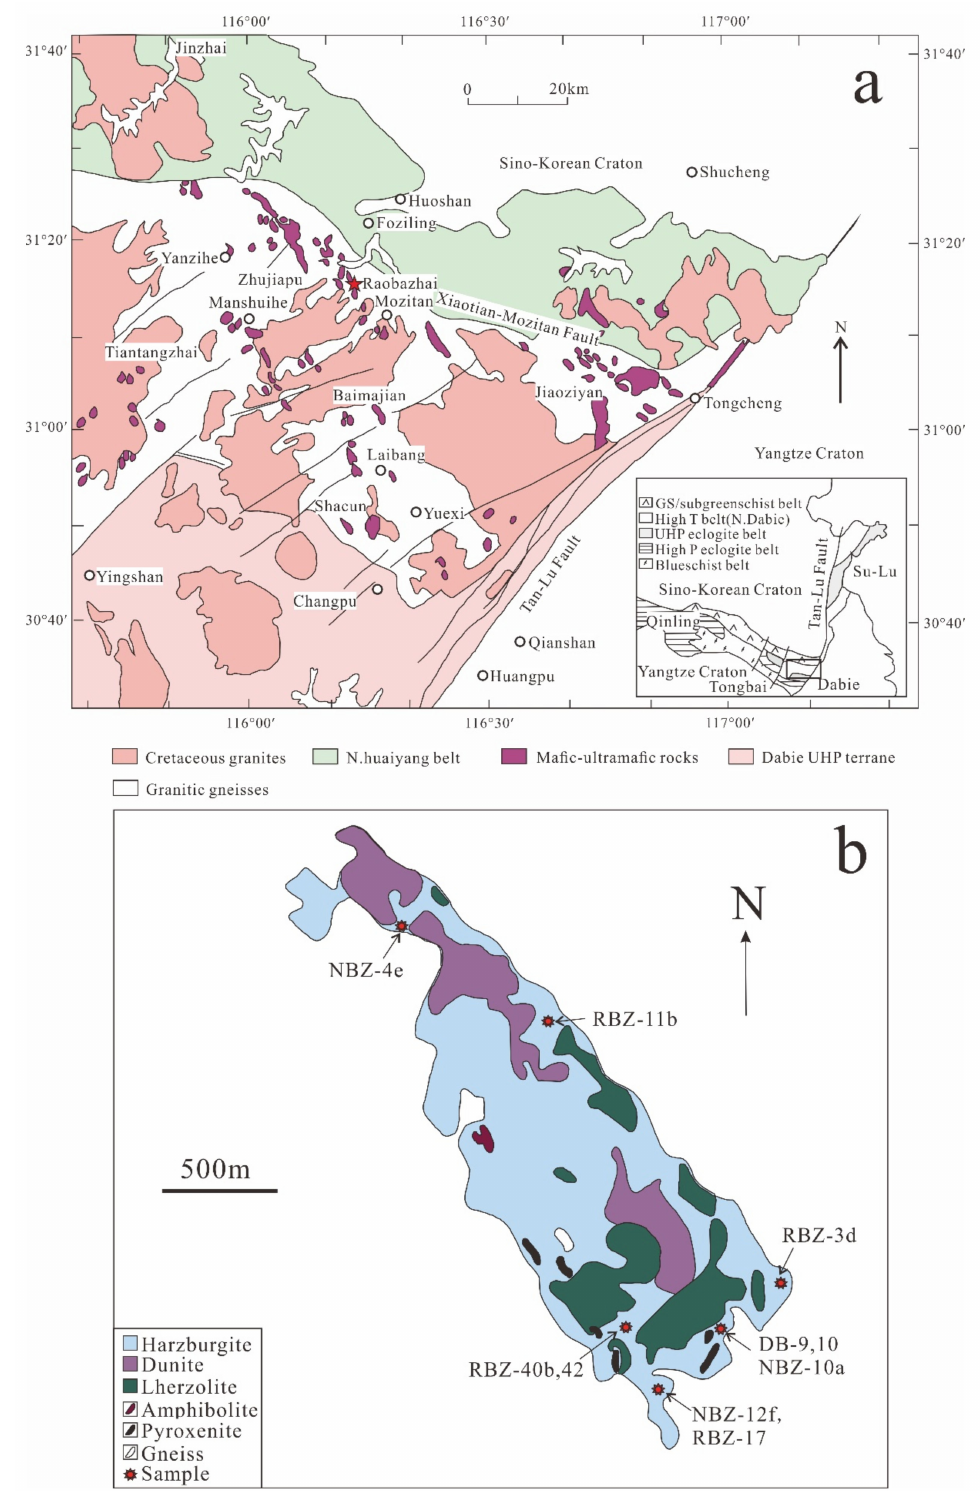
Figure 1. Simplified geological maps of ( a ) Dabie complex and ( b ) the Raobazhai complex. After